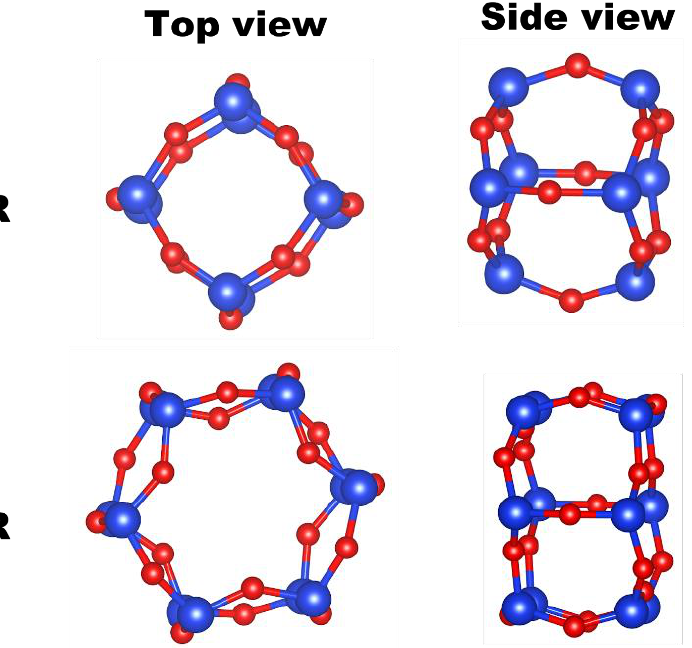
Figure 1. A double 4-members ring (D4R) and double 6-members ring (D6R) as examples of SBUs. Red atoms are oxygen and blue atoms are silicon or aluminium atoms.